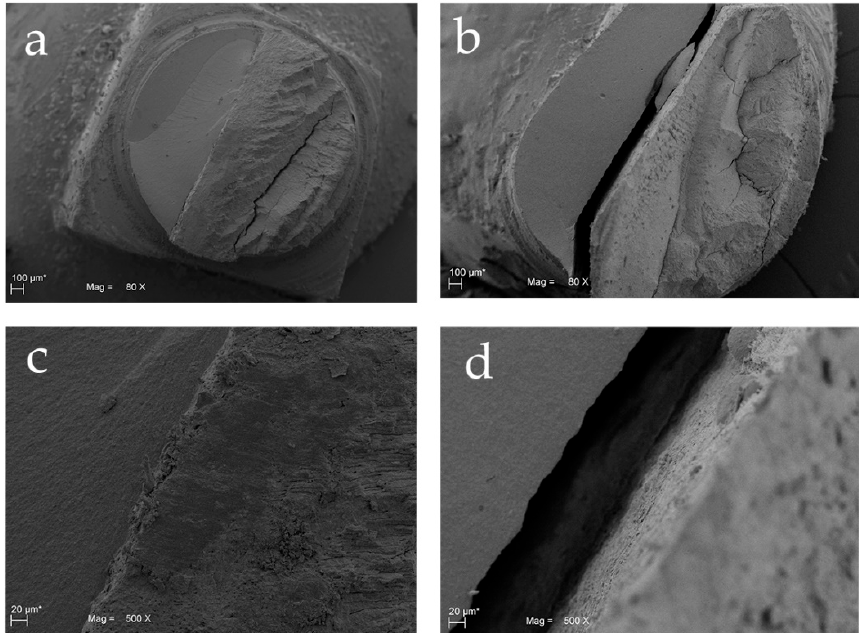
Figure 4. Scanning electron microscope (SEM) of Group 1 (Test) and Group 2 (Control): ( a ) SEM image of Group 1 at 80 × magnification. The fracture involved dentin with several direction changes; ( b ) SEM image of Group 2 at 80 × magnification. The fracture involved both dentin and the composite with direction changes; ( c ) Detail of Group 1 (interface) at 500 × magnification; ( d ) Detail of Group 2 at 500 ×